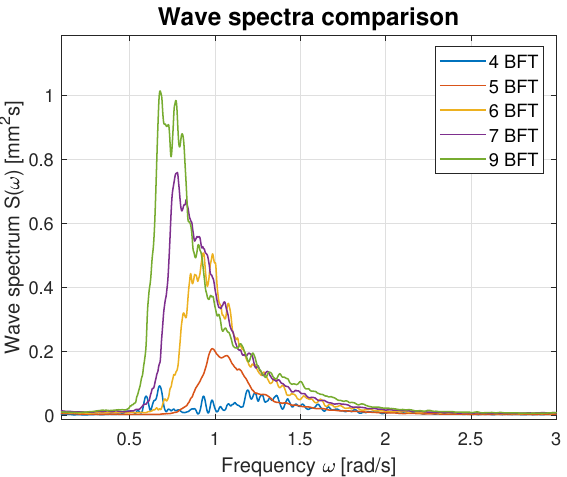
Figure 15. Empirical wave